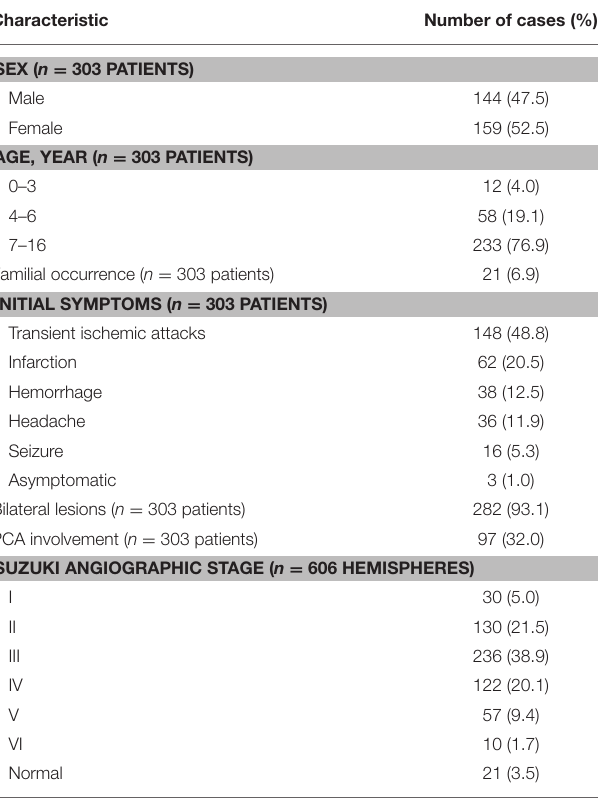
TABLE 1 | Clinical features of 303 children with moyamoya disease at presentation.